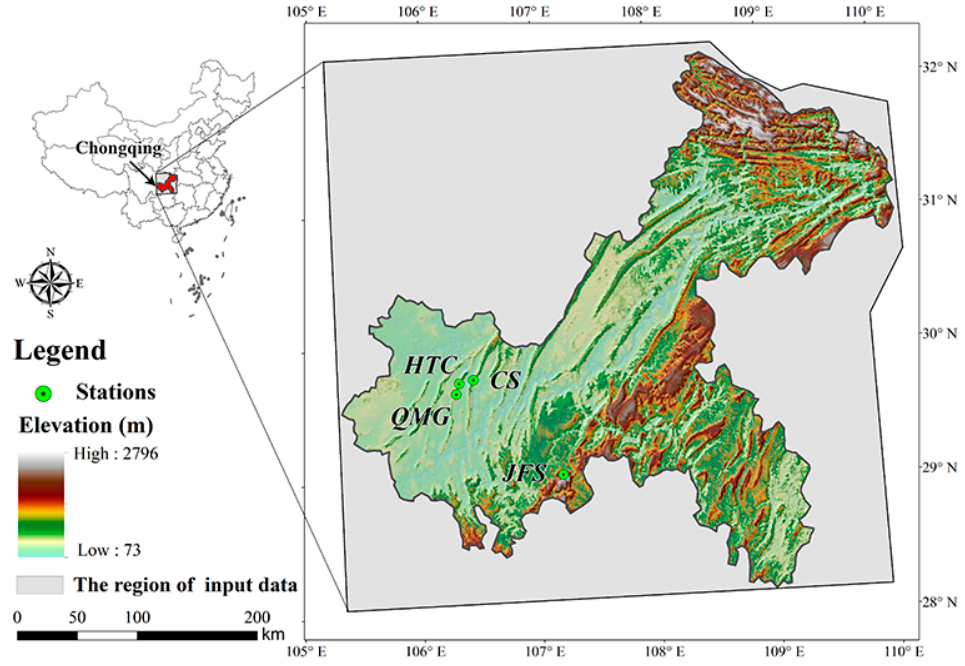
Figure 1. The location of the study area and location of validation